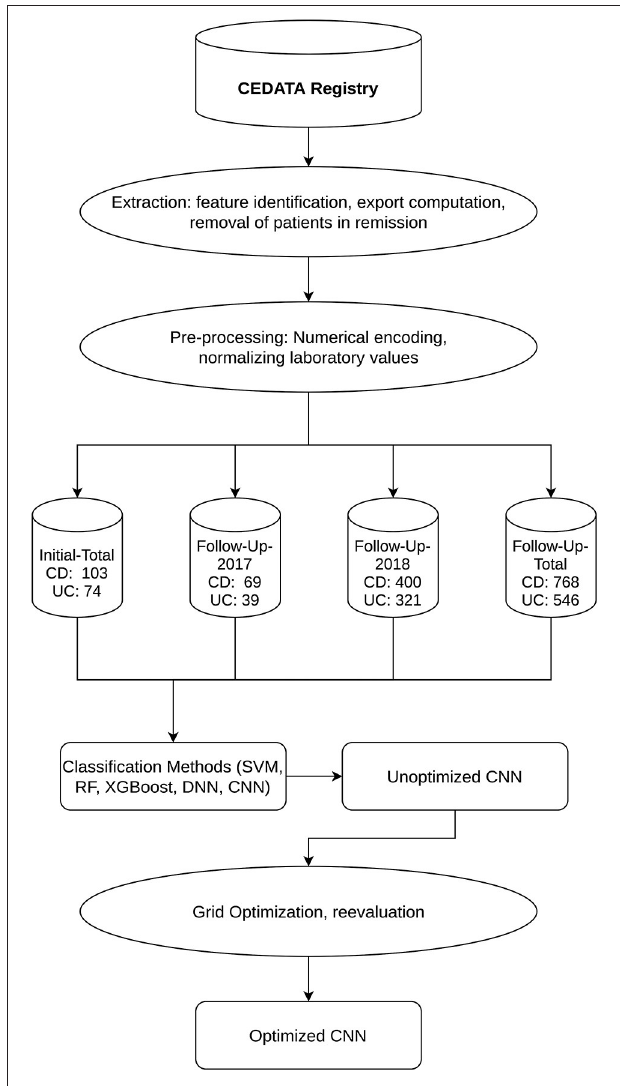
FIGURE 1 | Workflow and Datasets displays the outline of the applied methodology as well as the resulting datasets and their segmentation into CD and UC